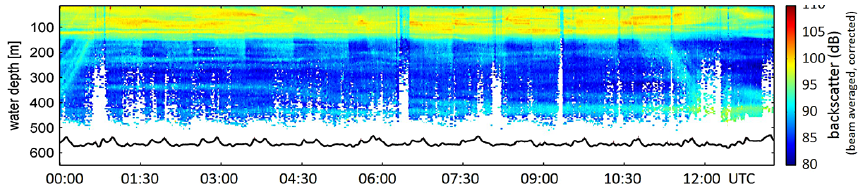
Fig. 7. ADCP-derived backscatter data obtained during a 13h stationary measurement from 00:00 to 13:00UTC on 24 March 2012. ADCP data were recorded simultaneously to the Yoyo CTD station GeoB 16316 (see Table 1). This backscatter record shows the upward (0:00– 0:30UTC, local sunset) and downward (11:30–12:00UTC, local sunrise) migration of the zooplankton. Probably biased data close to the seafloor have been omitted.